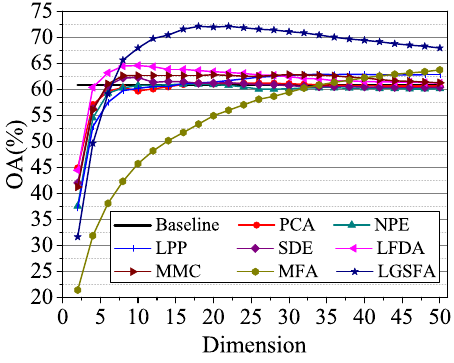
Figure 12. OAs with respect to different dimensions on the Indian Pines data